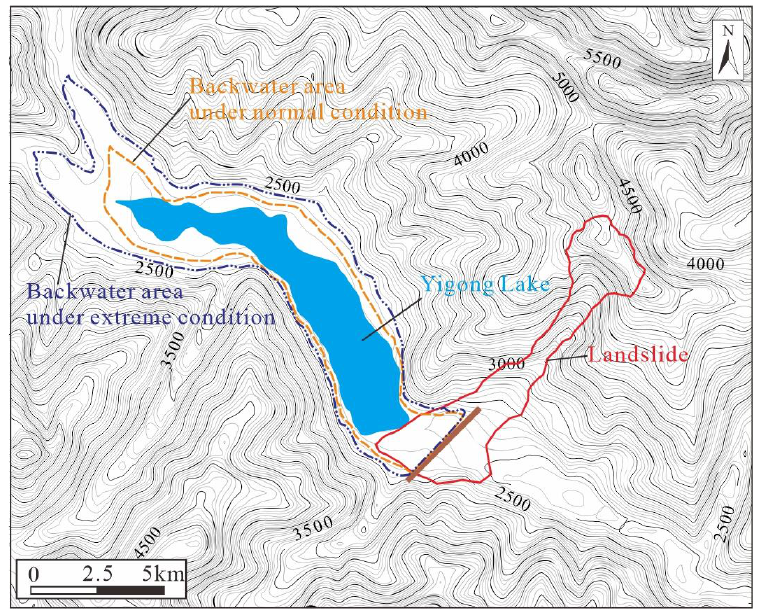
Figure 12. Range of backwater area under different simulation